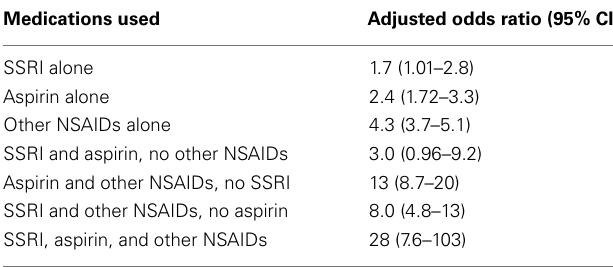
Table 4 | Risk of upper gastrointestinal bleeding as a function of current use of SSRIs, aspirin, and other